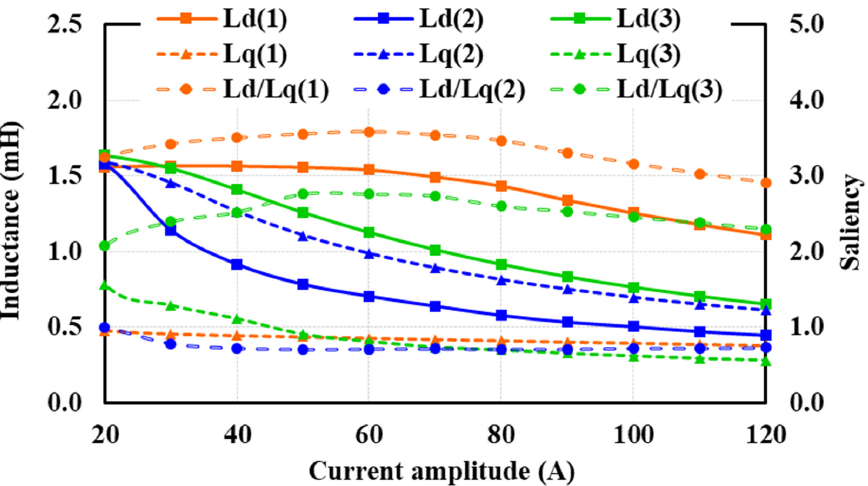
Figure 7. Inductance and saliency vs current magnitude for FI-PMa-SynRM (1) , Inset SPMSM model (2) , and SynRM model (3) . and SynRM model (3)